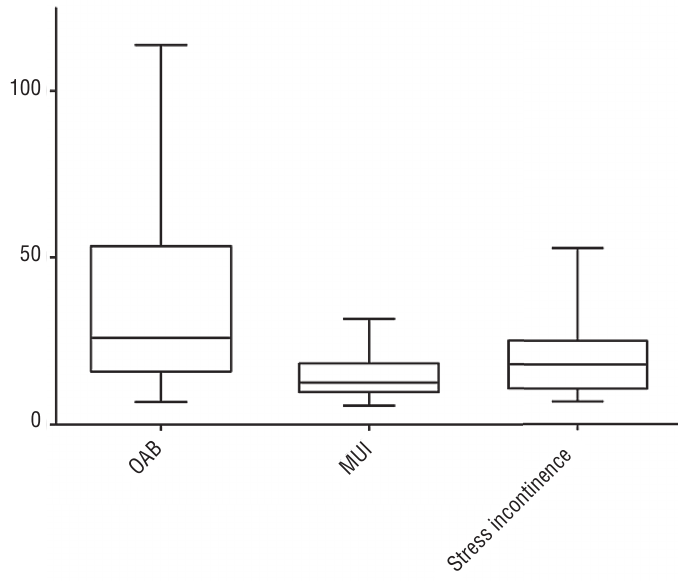
Figure 2 - Diagram of variance of delta pressure between the